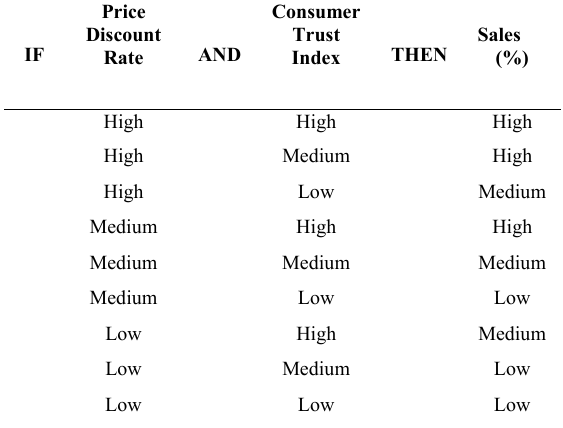
Table 2. Fuzzy rule base for descending rate and constant rate campaigns